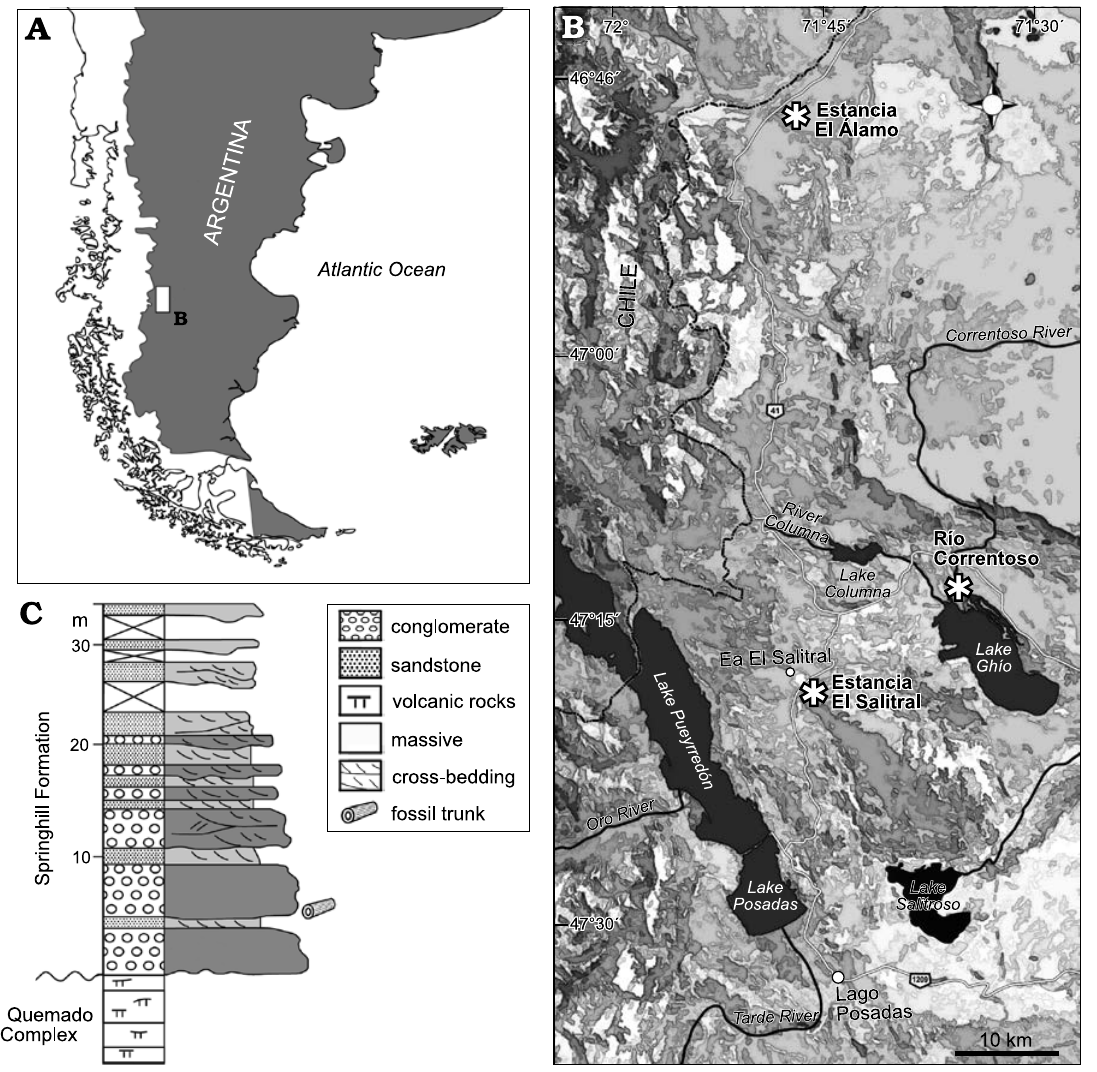
Fig. 1. Map showing location od the study area ( A ) and the three fossiliferous localities (asterisked) of the Springhill Formation, Santa Cruz Province, Argentina ( B ). C . Stratigraphic section of the Springhill Formation in the Estancia El Álamo